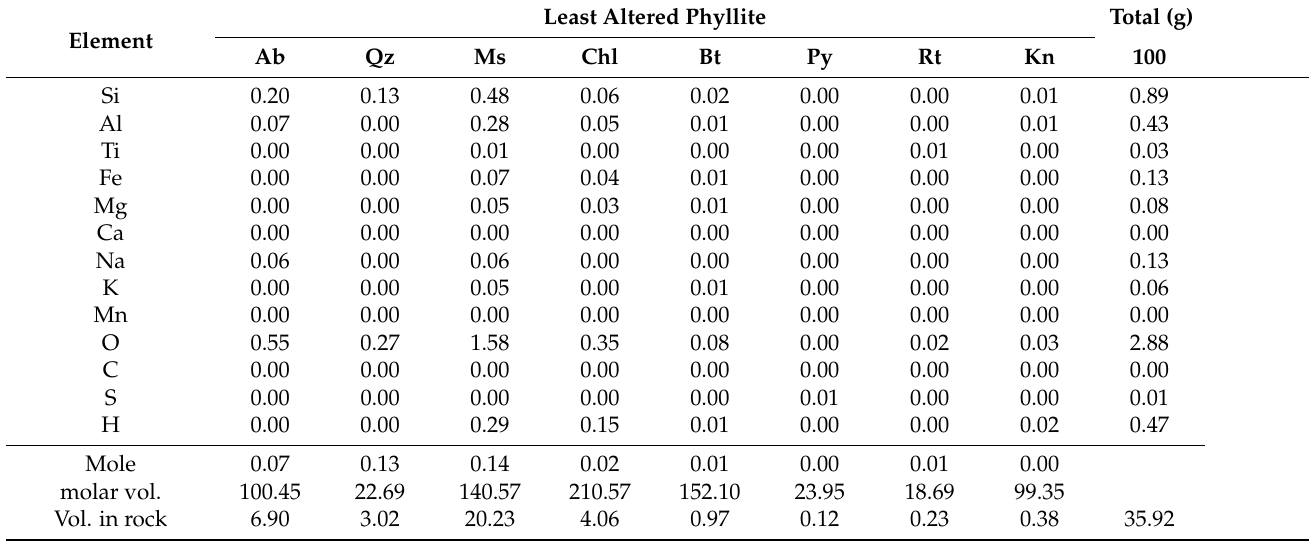
Table 8. Quantified compositional data for the least altered phyllite and the